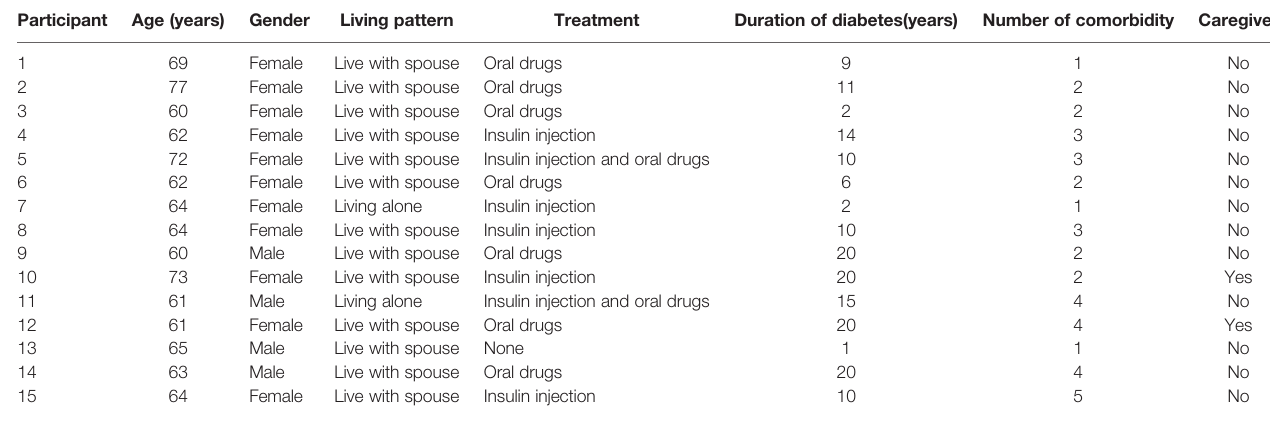
TABLE 1 | Demographic data of participants